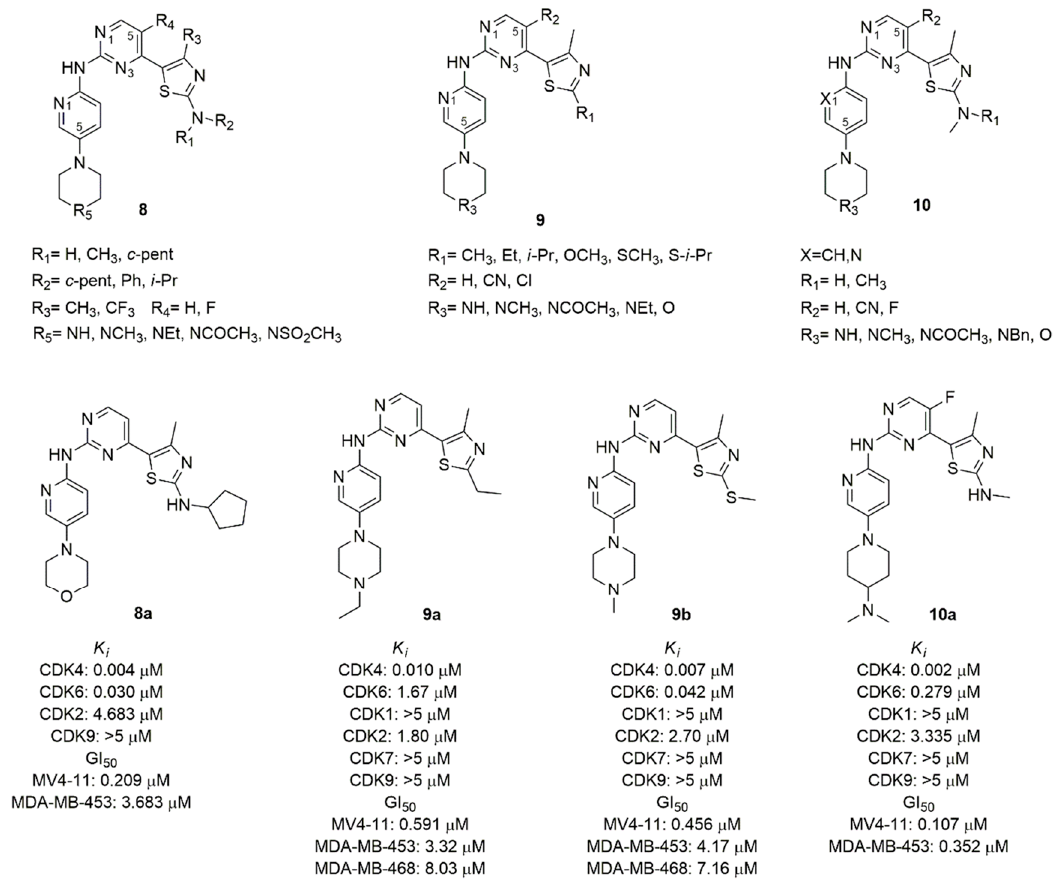
Figure 5. CDK4/6 inhibitors based on thiazolyl-pyrimidine